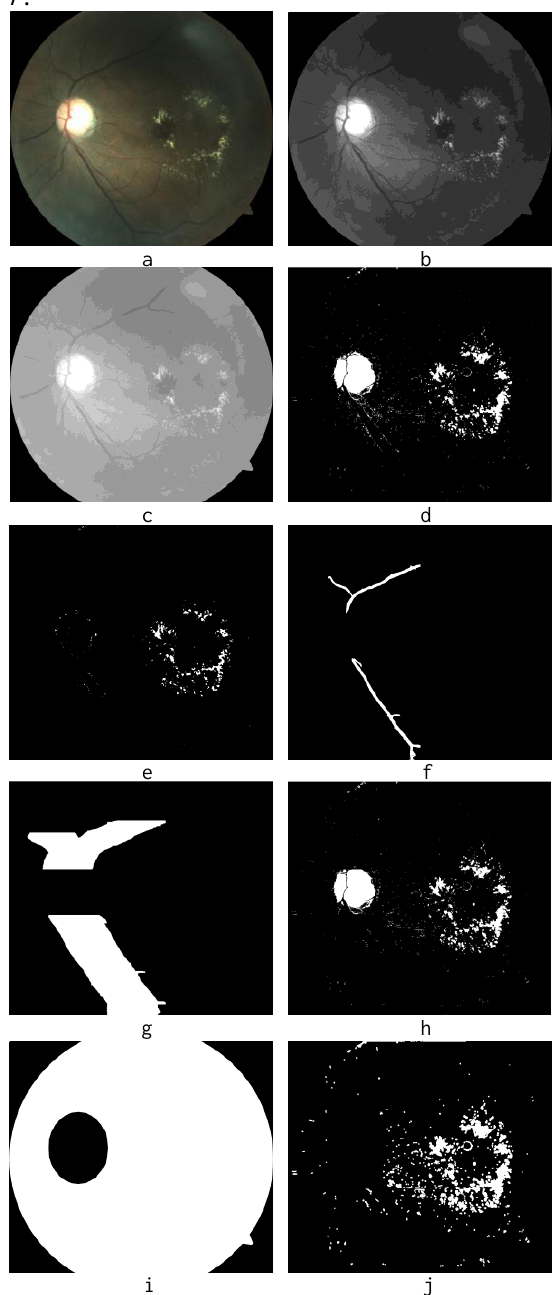
Figure 7. The results of different stages of the proposed algorithm, a) input image in RGB color space, b) green channel of RGB color space, c) L channel of Luv color space, d) result of the first stage of detection, e) result of the second stage of detection, f) the segmented main vessels, g) Mark around the main vessels (about 400 pixels), h) results of the post processing steps, i) the optic disk removing mask, j) final output of the proposed detection algorithm .